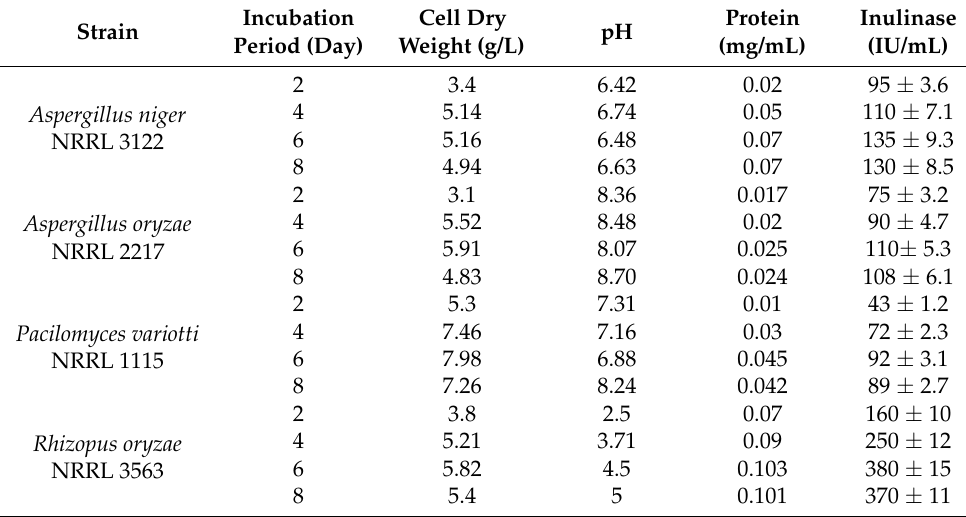
Table 3. Screening of cultures for inulinase production. Strain